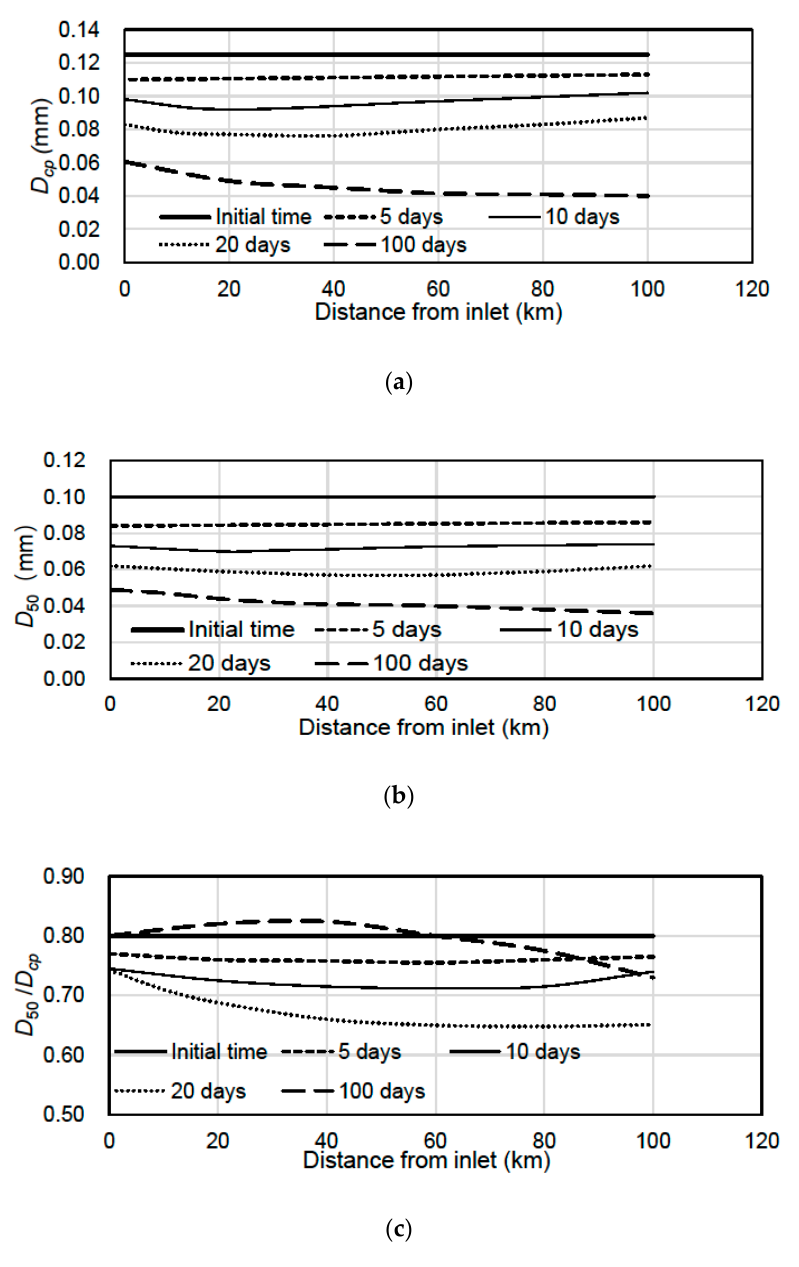
Figure 3. Spatial variation in the bed material under deposition conditions. ( a ) D cp ; ( b ) D 50 ; and ( c ) D 50 / D cp .